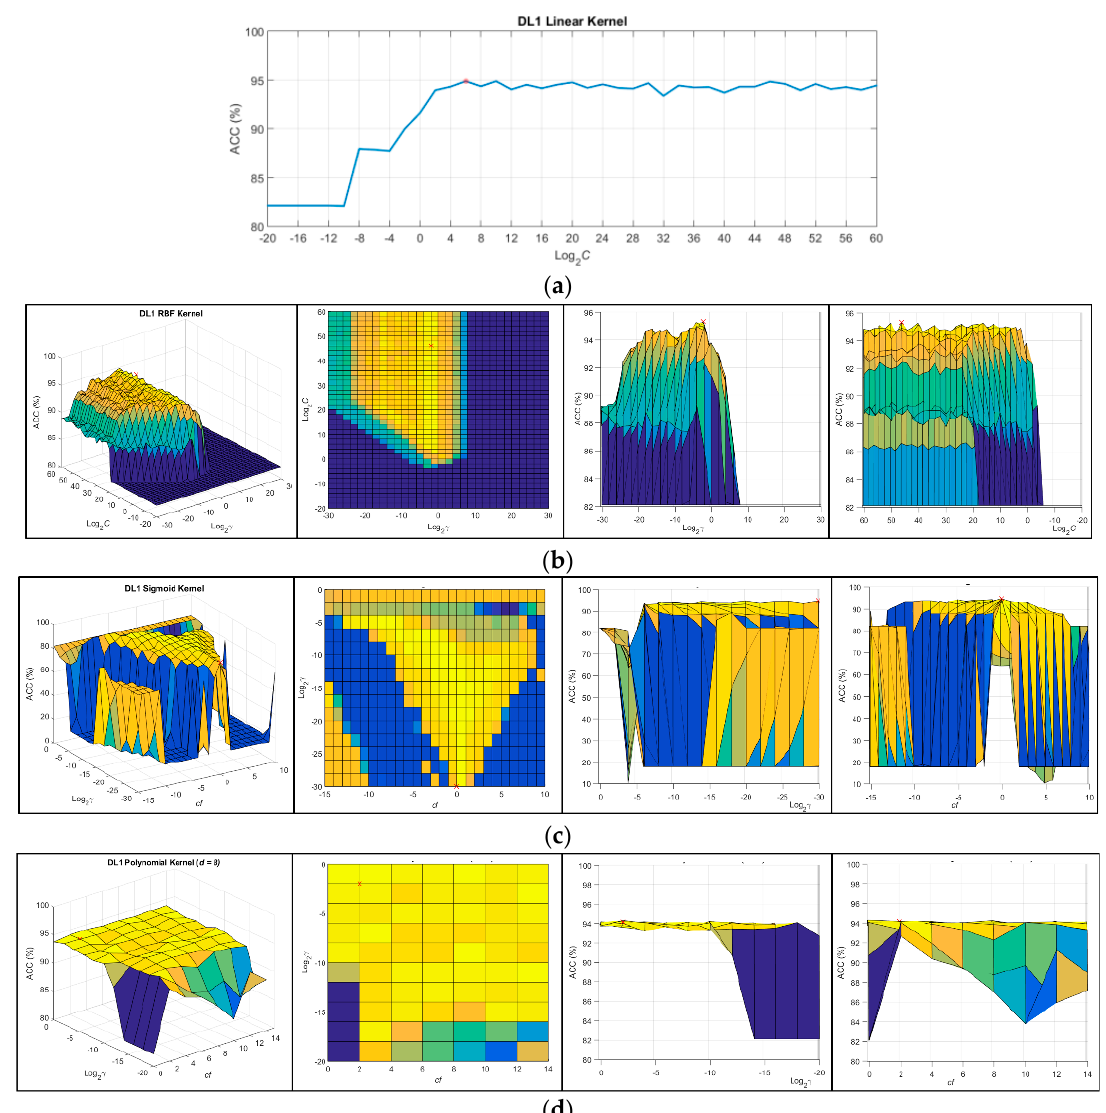
Figure 3. Grid search representation of the ACC results obtained in the coarse tuning for each kernel employing the DL1. ( a ) Linear kernel results; ( b ) RBF kernel results; ( c ) Sigmoid kernel results; ( d ) Polynomial kernel results with a fixed degree parameter ( d = 8).